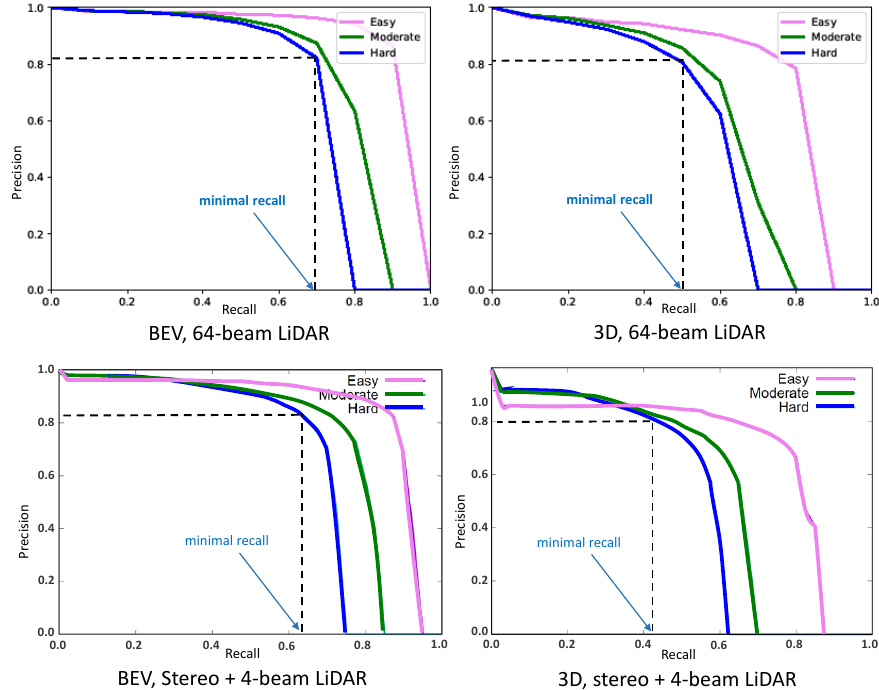
Figure 7. Precision–recall (P–R) curves obtained for the detection of 3D objects (right column) and 2D objects in BEV (left column). In this graph, the minimal recall shows the first recall value obtained when the P–R curve starts to drop sharply and the precision score is still higher or equal to